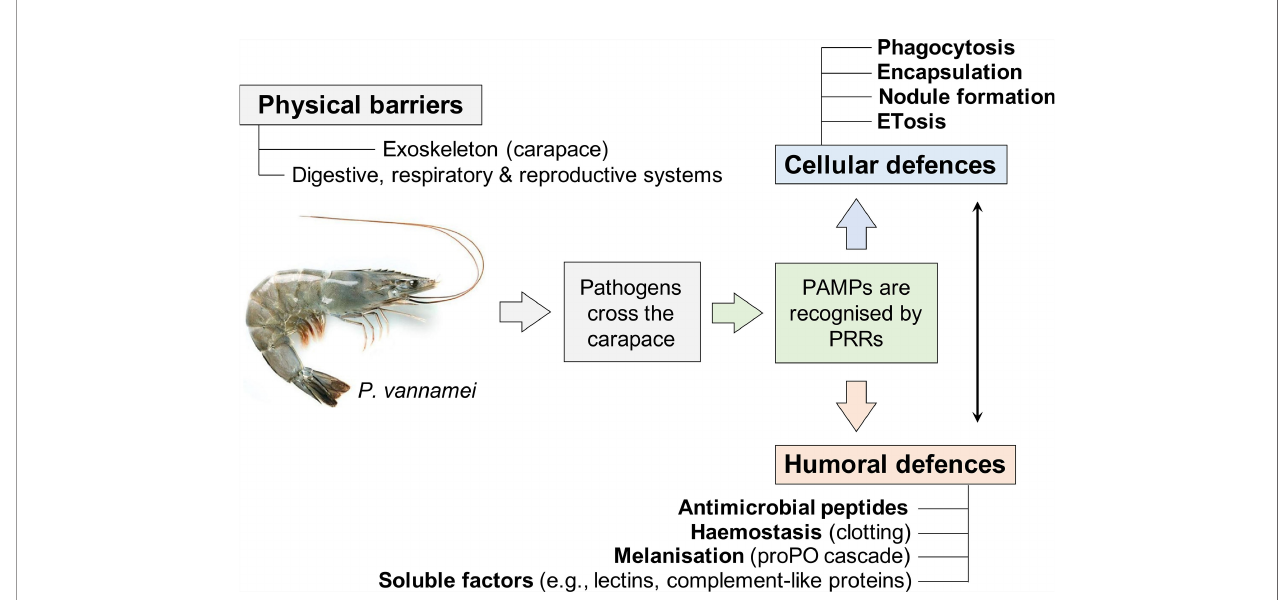
FIGURE 1 | Innate immune defences of penaeid shrimp to infectious disease. Should the disease-causing agents circumvent the physico-chemical barriers, their ligands (pathogen associated molecular patterns, PAMPs) are intercepted by pathogen recognition receptors (PRRs) freely dissolved in the haemolymph or located at the surface of haemocyte plasma membranes. Such recognition triggers a multitude of immune-related cascades including the ingestion of pathogens (phagocytosis), the ensheathment of pathogens – nodules for numerous microparasites, and capsules for larger parasites – and the release of chromatin extracellular traps (ETosis). Bacteria, fungi, and viruses are targeted directly by a series of microbiostatic and microbicidal factors (e.g., lysozyme, lectins) and indirectly by toxic by-products and intermediates of melanogenesis (via the activation of the proPhenoloxidase (proPO) cascade). There is much crosstalk between the cellular and humoral defences (indicated by the black arrow), such as, haemolymph